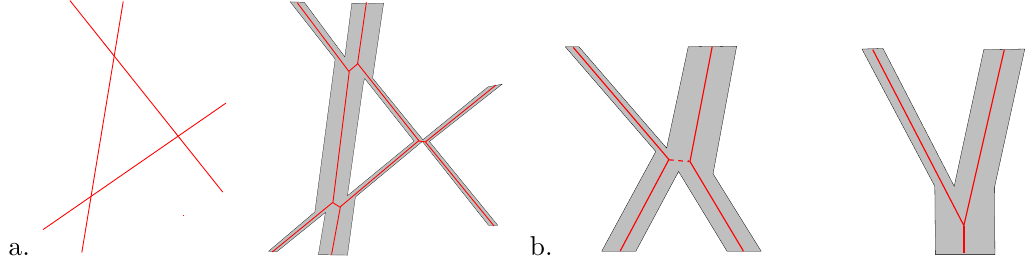
Figure 3 . The effect of the λ R -deformation on relativistic scattering processes. The particles gain a width in a consistent fashion in space-time, as if “grout” were added between tiles. a. elastic scattering; b. inelastic